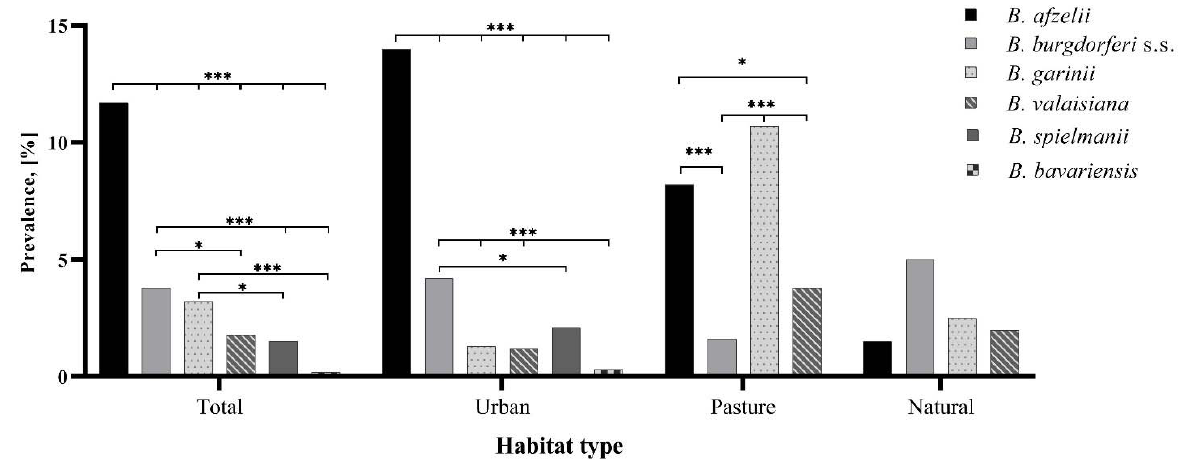
Figure 2. Overall prevalence of detected Borrelia genospecies in each habitat type. The percentages of positive ticks per genospecies for every single habitat are given. Significant differences between species infection rates are indicated above the bars; *, p < 0.05; ***, p < 0.001.